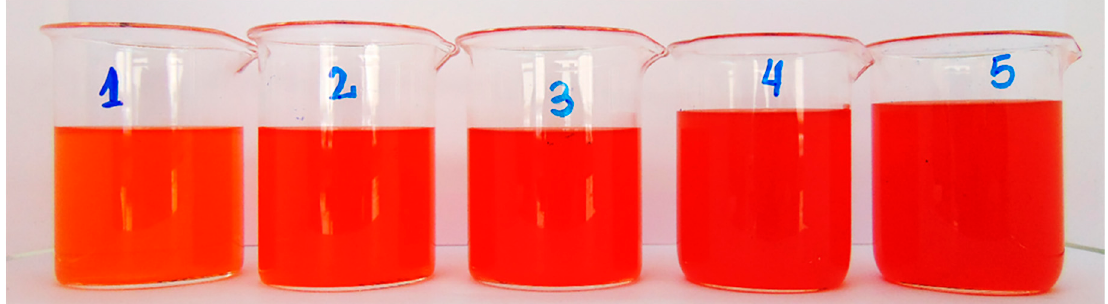
Figure 3. Photograph of isotonic beverages pigmented with the addition of astaxanthin oleoresin emulsion (AOE), where 1 and 5 are the lowest and highest concentrations, respectively.